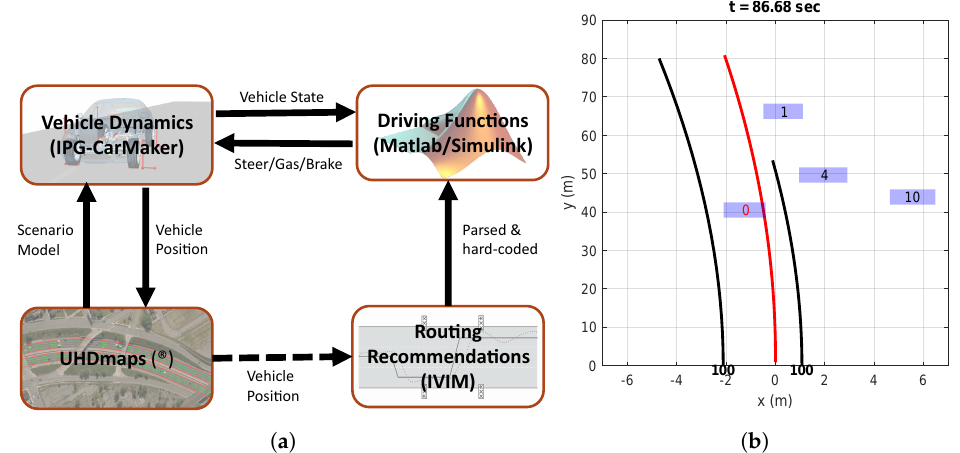
Figure 3. Simulation environment, setup, and ego vehicle aligned visualization. ( a ) Co-simulation architecture utilizing Matlab/Simulink and IPG Carmaker. ( b ) Visualization of objects (blue boxes) and assigned ID, lane markings and quality of detection (black), and ego prediction (red).